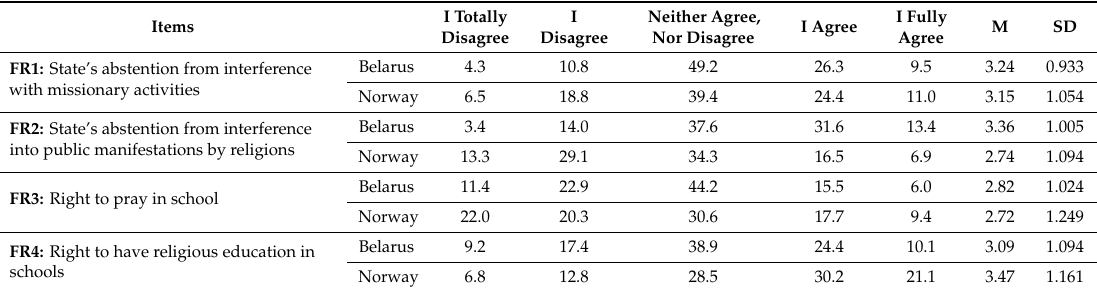
Views on religious freedom in Belarus and Norway (frequencies (%), means and standard